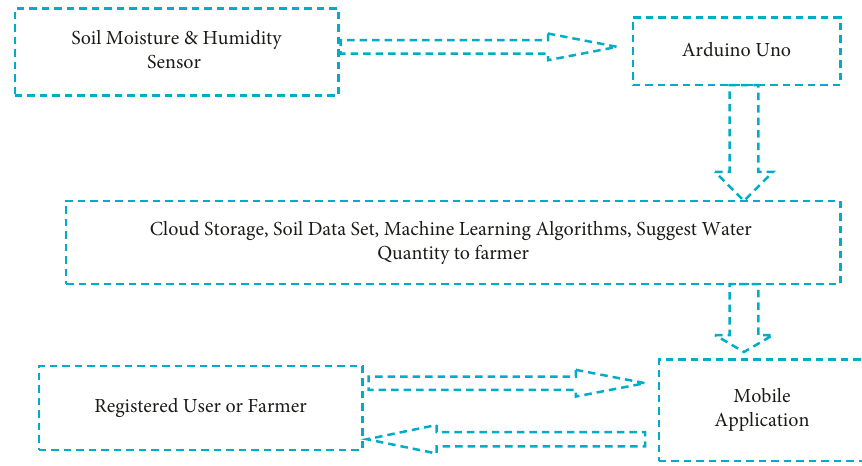
Figure 1: A framework for smart